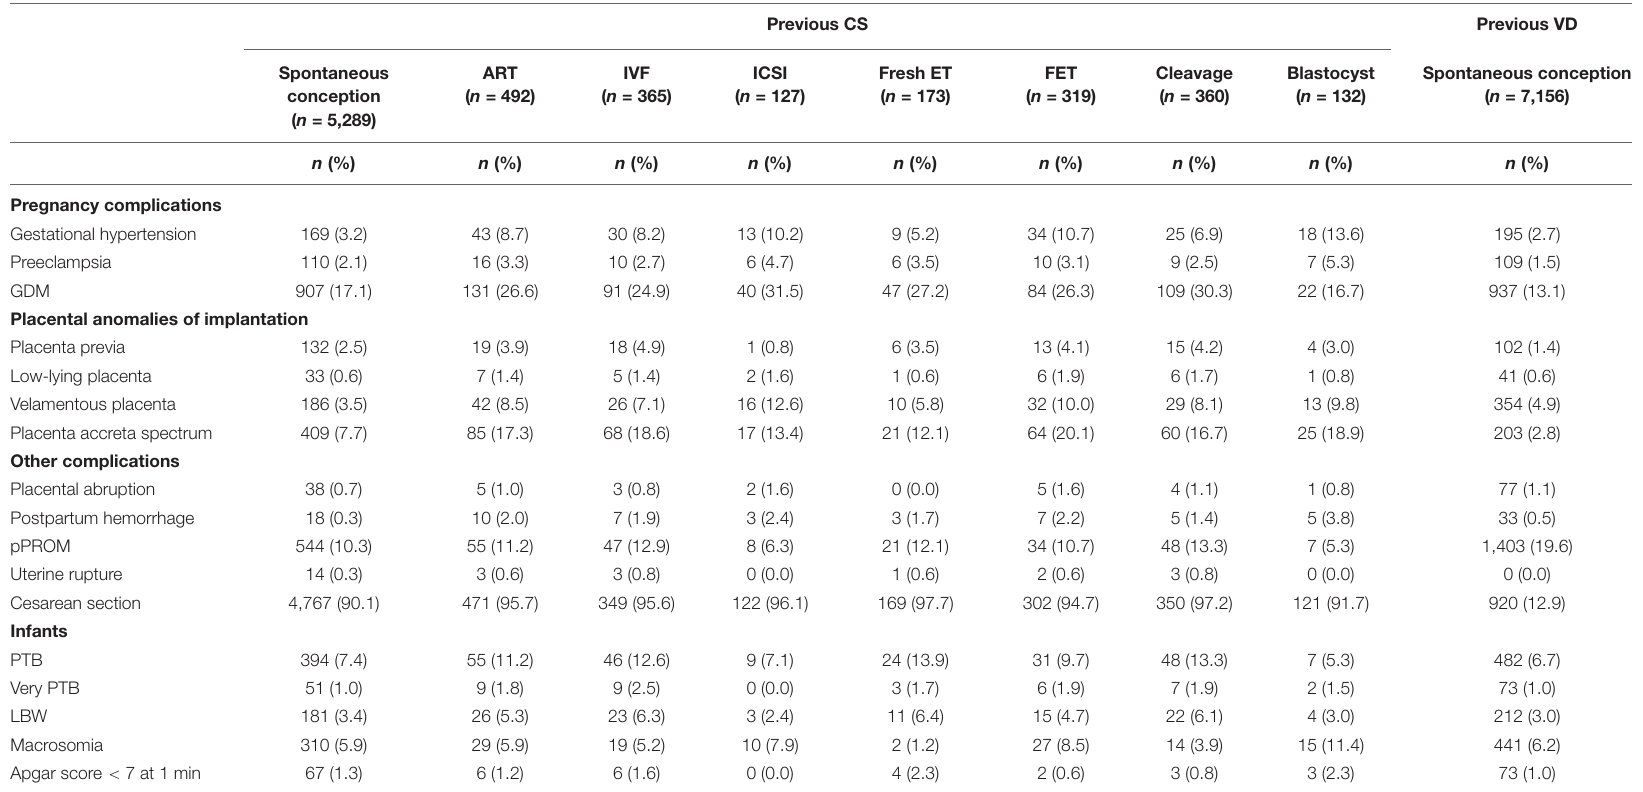
TABLE 3 | Obstetric and perinatal outcomes in subsequent singleton pregnancies according to mode of delivery at the first